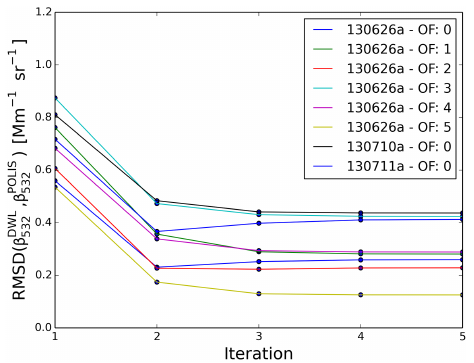
Figure 18. Root-mean-square difference (RMSD) between the backscatter coefficients derived from the DWL and POLIS, calcu- lated for each iteration and overflight. The backscatter coefficients of the three layers are used for the calculation.